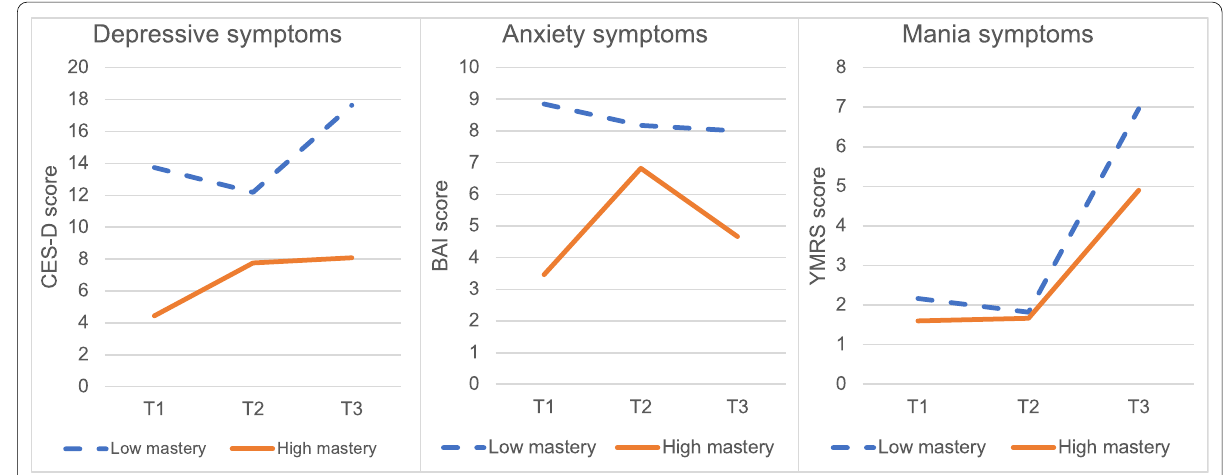
Fig. 3 The course of depressive, anxiety and mania symptoms, separately presented for the low and high mastery group. CES-D, Center of Epidemiological Studies Depression Scale; BAI, beck anxiety inventory; YMRS, young mania rating